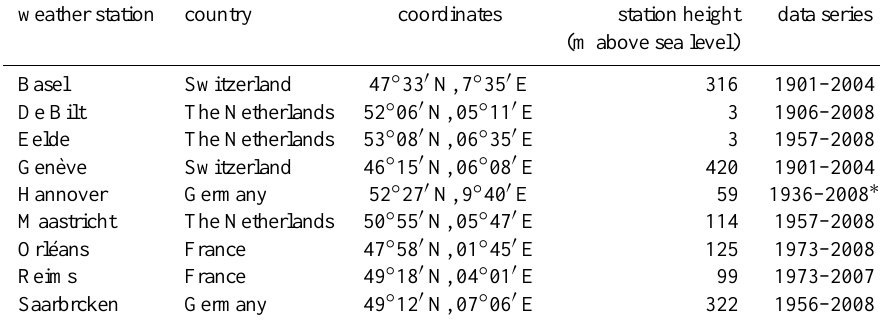
Table 1. Description of the nine weather stations from which the meteorological record was used in our